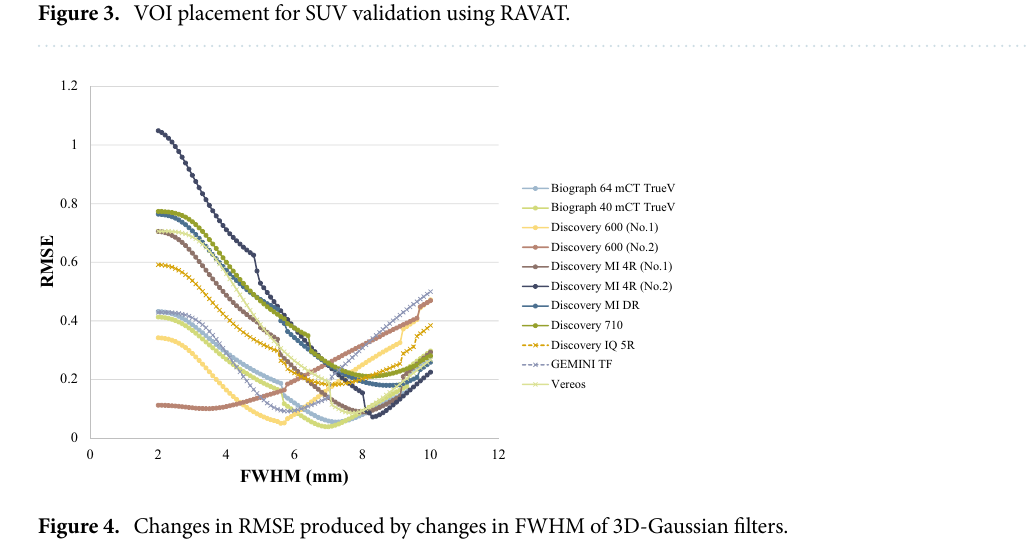
Figure 4. Changes in RMSE produced by changes in FWHM of 3D-Gaussian